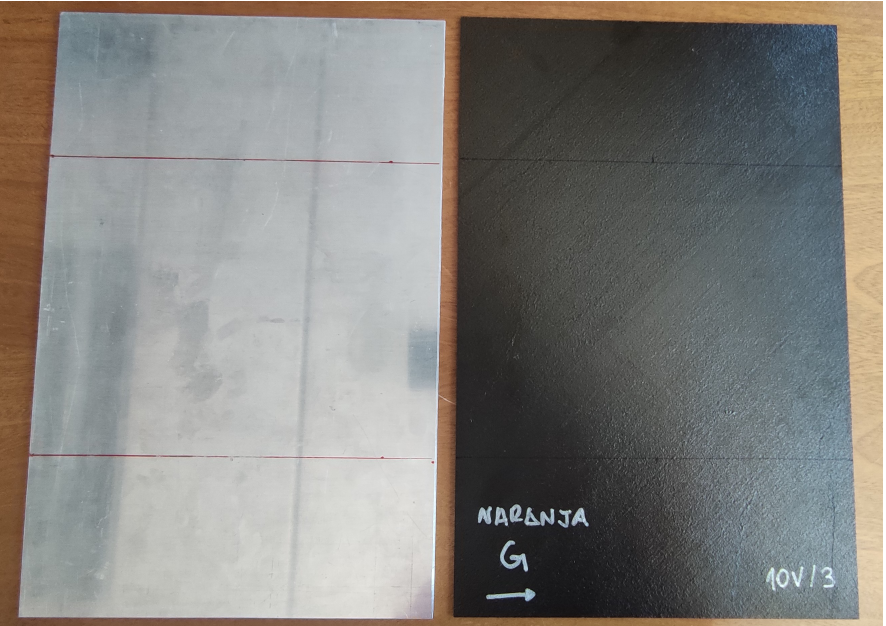
Figure 1. Microstrip test pieces: aluminum ( left ) and CFC sample code named “ORANGE” ( right ).